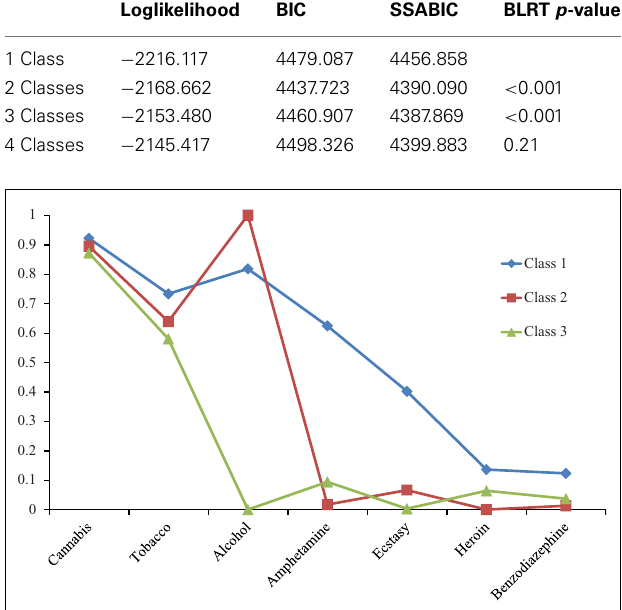
FIGURE 1 | Probability of last month substance use from the 3-class solution